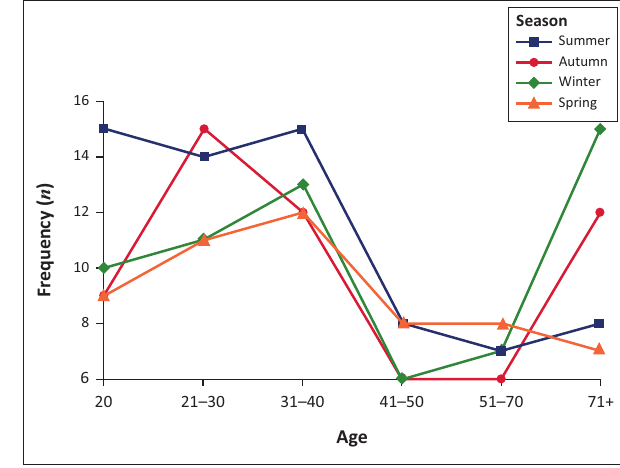
FIGURE 4 : Seasonality of suicide by age in